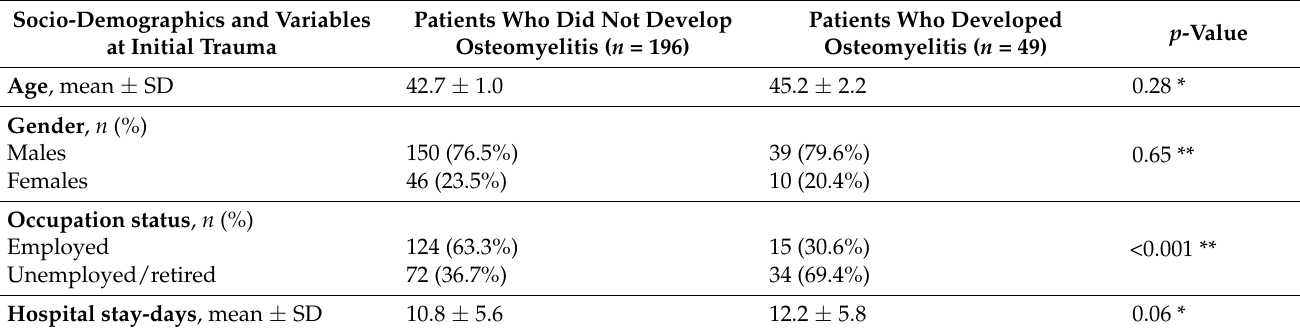
Table 2. Bivariate analysis of sociodemographics and variables related to initial trauma with os-